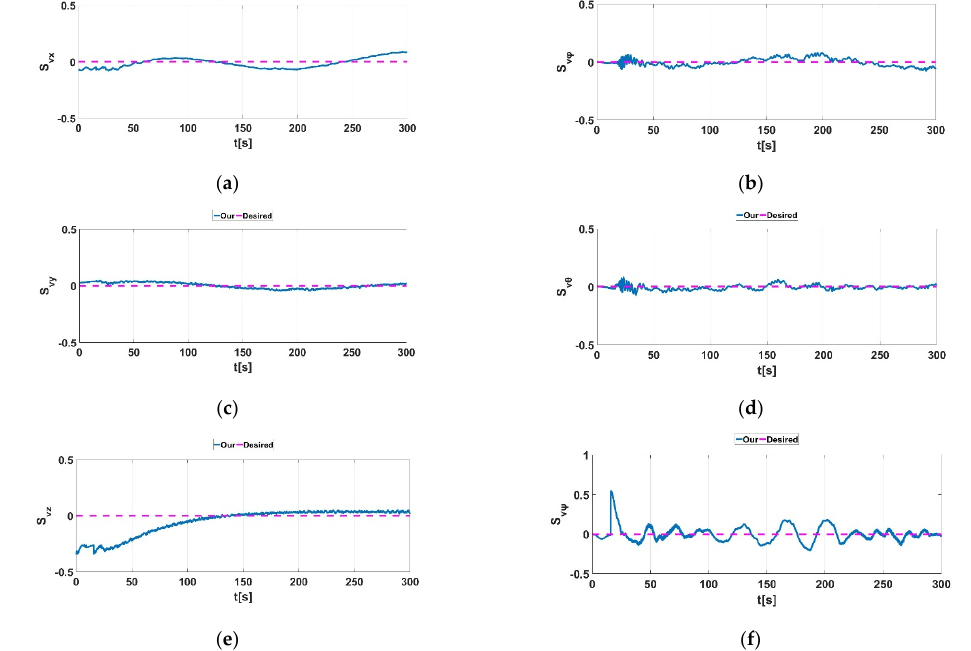
Figure 10. Outer − loop PID sliding surface 𝑺 𝒗 (cid:3556) . ( 𝐚 ) 𝑆 𝑣𝑥 ; ( 𝐛 ) 𝑆 𝑣𝜑 ; ( 𝐜 ) 𝑆 𝑣𝑦 ; ( 𝐝 ) 𝑆 𝑣𝜃 ; ( 𝐞 ) 𝑆 𝑣𝑧 ; ( 𝐟 ) 𝑆 𝑣𝜓 .